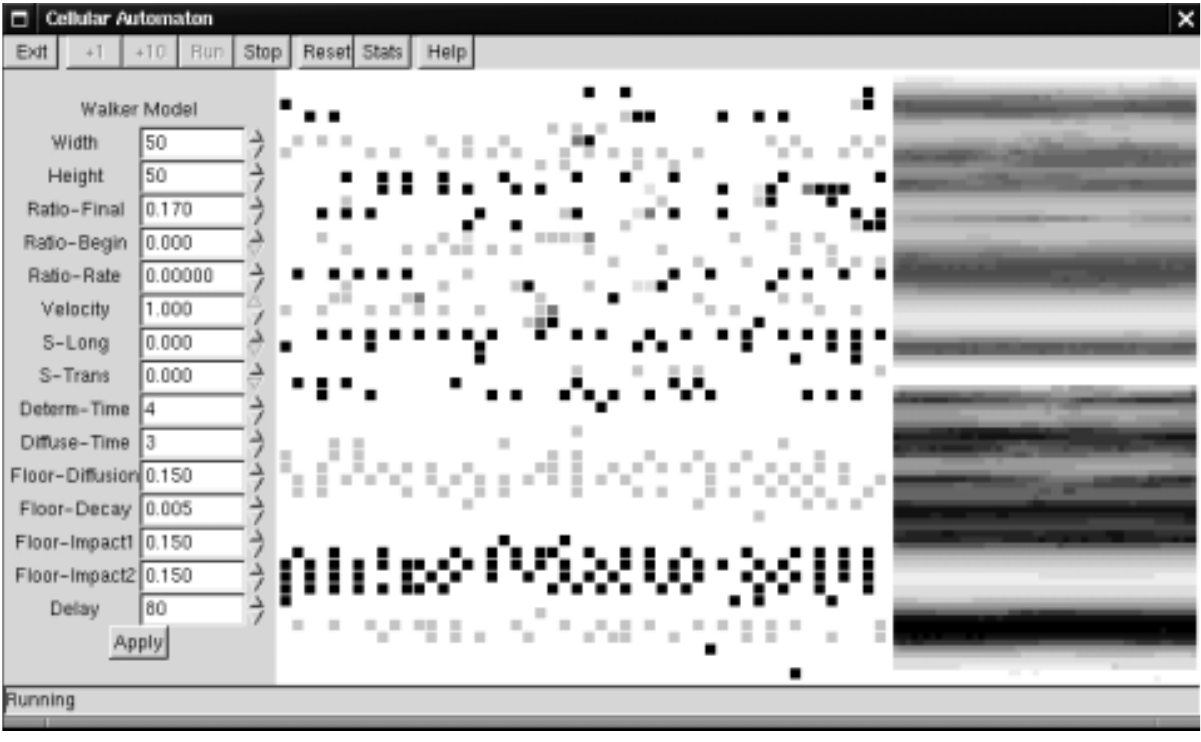
Figure 7 Snapshot from a simulation of a corridor with two groups of pedestrians moving in opposite directions. The left part shows the parameter control. The central window is the corridor and the light and dark squares are right- and left-moving pedestrians, respectively. The right part shows the floor fields for the two species.